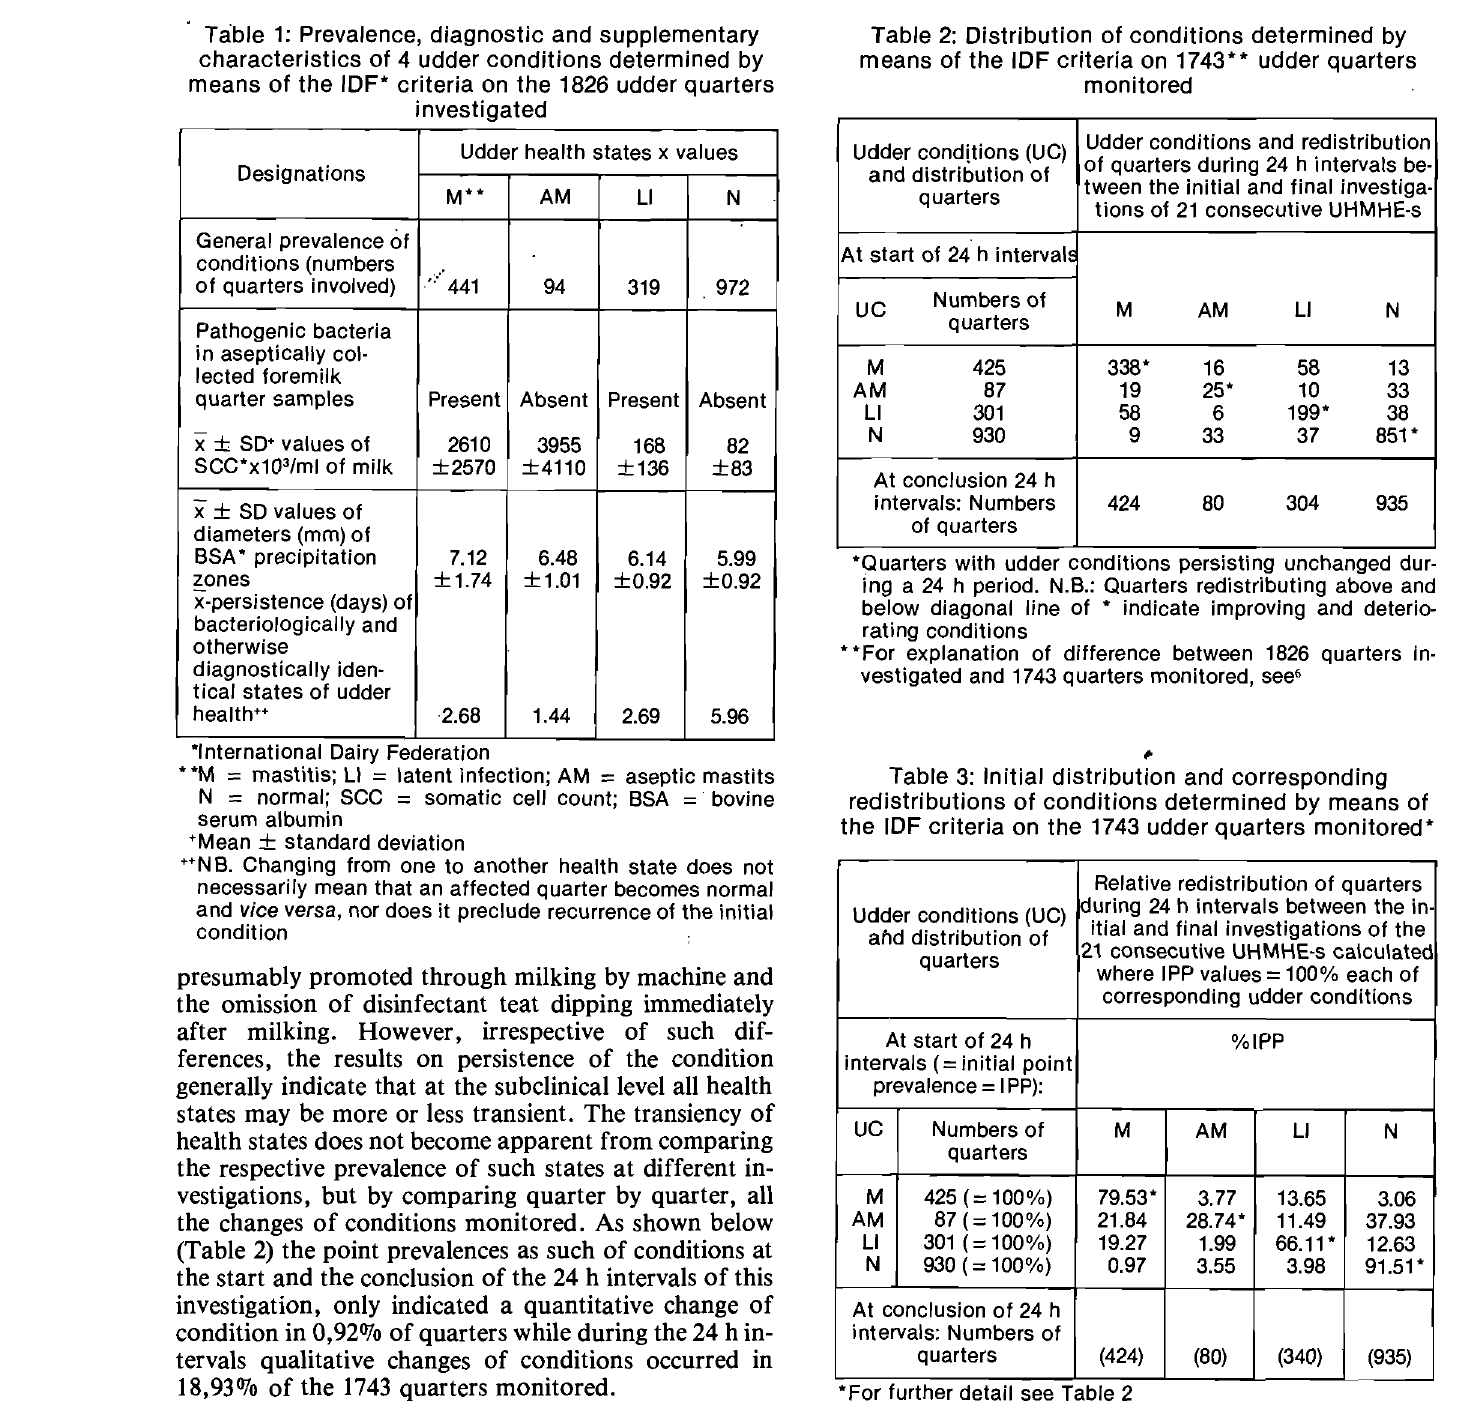
Table 1: Prevalence, diagnostic and supplementary characteristics of 4 udder conditions determined by